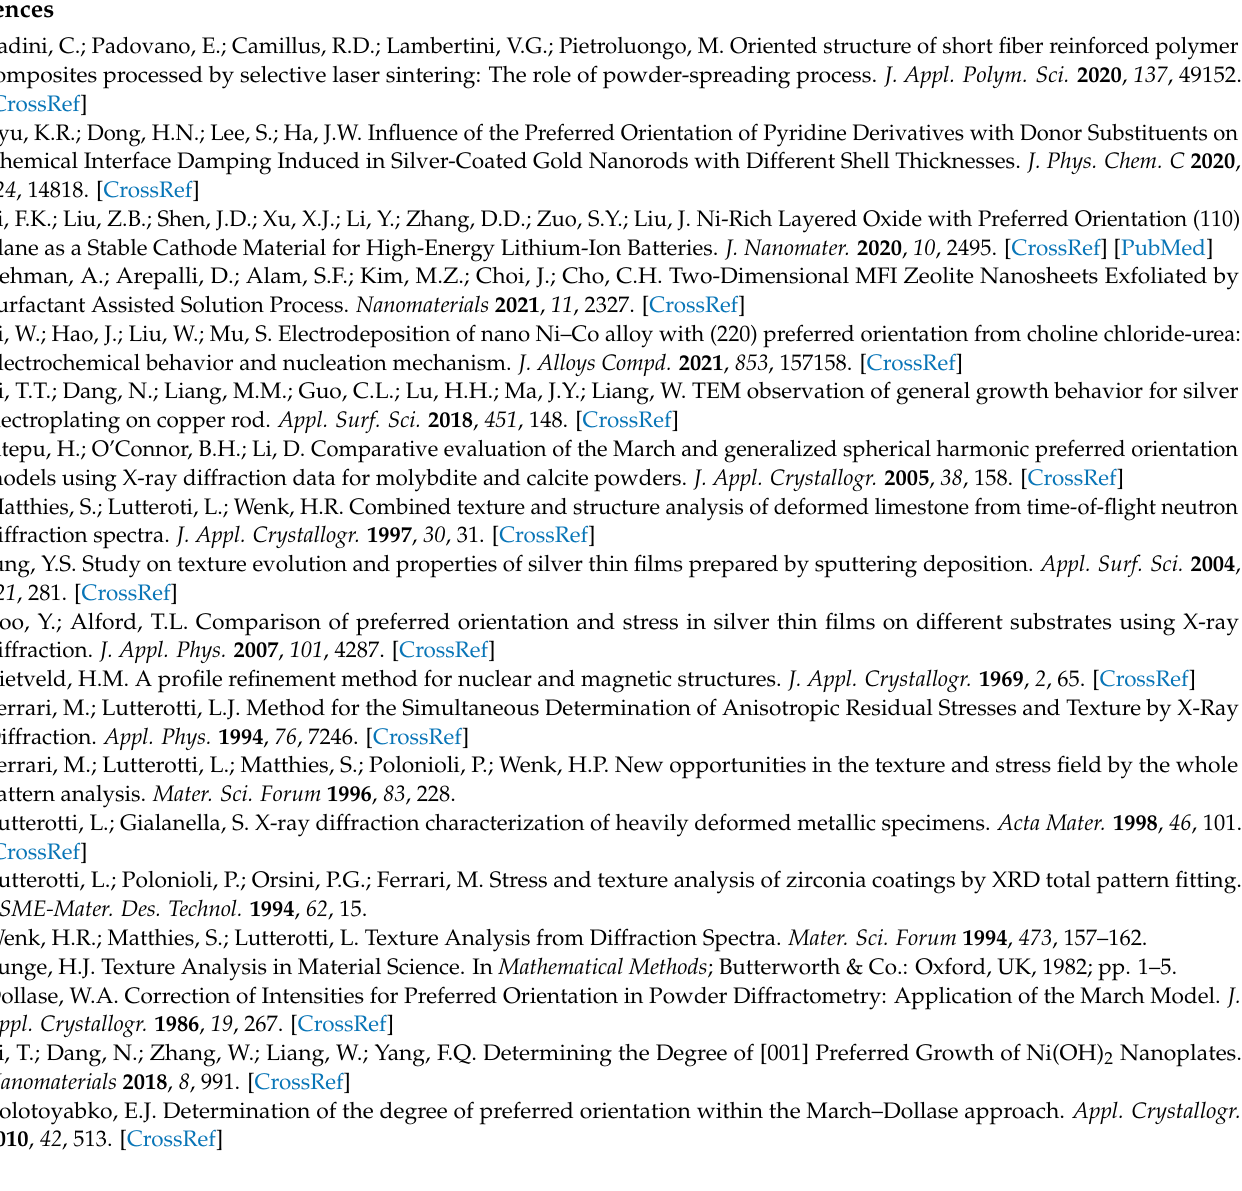
Rietveld method and quantitative texture analysis (RM+QTA). Table S1: Refined crystal structure, microstructure, and preferred orientation index for silver film in materials analysis using diffraction (MAUD). Table S2: Refined preferred orientation index for silver film in the current density (0.3 A/dm 2 ) and different plating times with materials using diffraction